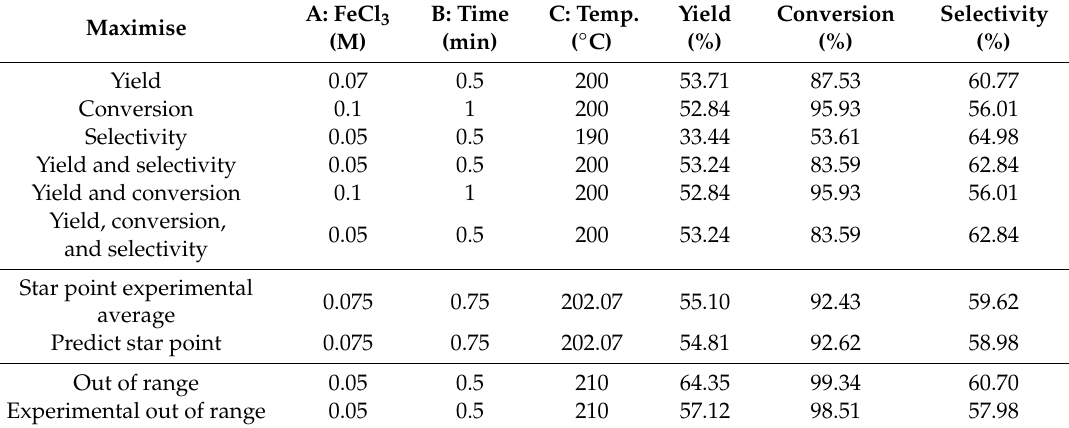
Table 5. Results of the optimization of the rotatable composite central